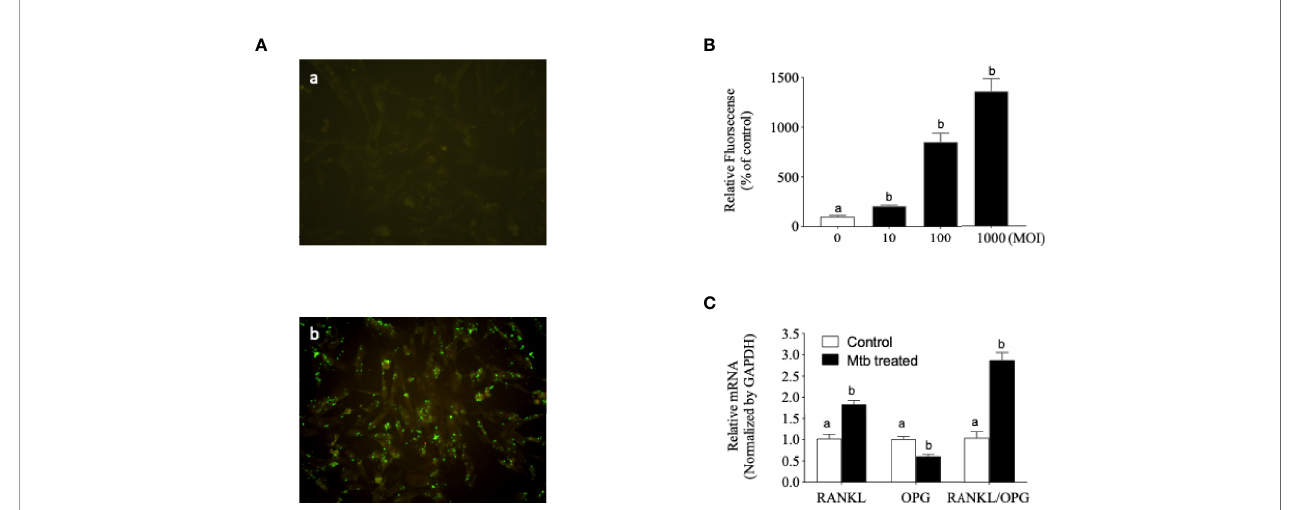
FIGURE 2 | Mycobacterium tuberculosis ( Mtb ) internalized human osteoblast cells and changed the receptor activator of NF- k B ligand (RANKL)/osteoprotegerin (OPG) ratio. (A) Fluorescence-labeled Mtb were cultured in Middlebrook 7H9 with OADC. Osteoblast cells were infected with the culture medium or Mtb for 5 h at a multiplicity of infection (MOI) of 20, and non-infected bacteria were removed by washing with phosphate-buffered saline (PBS) three times. ( a ) Control. ( b ) Mtb infection. Images are shown at ×200 original magni fi cation. (B) Fluorescence-labeled Mtb were co-cultured in accordance with the experimental procedure described in Materials and Methods . The internalized Mtb was measured based on the increased fl uorescence density. (C) Single-stranded cDNA was synthesized from the total RNA from Mtb -infected osteoblast cells, and RT-PCR was performed with the gene-speci fi c primers described in Materials and Methods . Means without a common letter differ. p < 0.05.